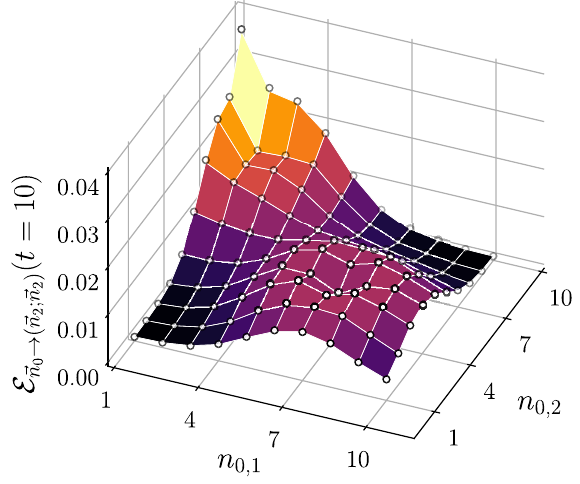
t Þ from any lattice FIG. 6. First-passage probability E ⃗ n 0 → ð ⃗ n 1 ; ⃗ n 2 Þ ð site ⃗ n 0 to either of two targets, located at (2,9) and (7,4), in a square domain with reflecting boundaries of size N ¼ 10 at time t ¼ 10 . At the location of the targets, the plot represents the return probability to the starting lattice without having been to the other target. The choice q 1 ¼ q 2 ¼ 1 = 3 has been selected for the n 1 ; n 2 ; t Þ in Eq. (21). The open white circles propagator P ⃗ n 0 ð represent the numerical inversion of Eq. (38), while the shaded surface represents the ensemble average of 10 6 stochastic simulations.